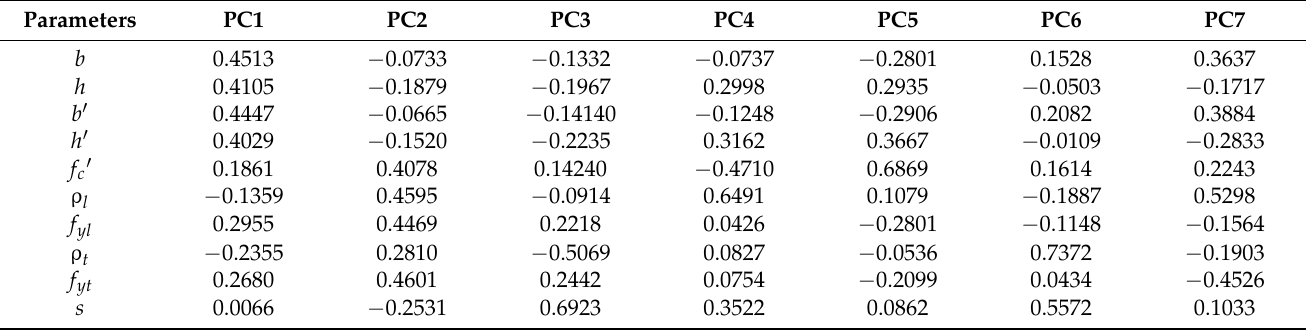
Table 2. Results of principal components analysis.